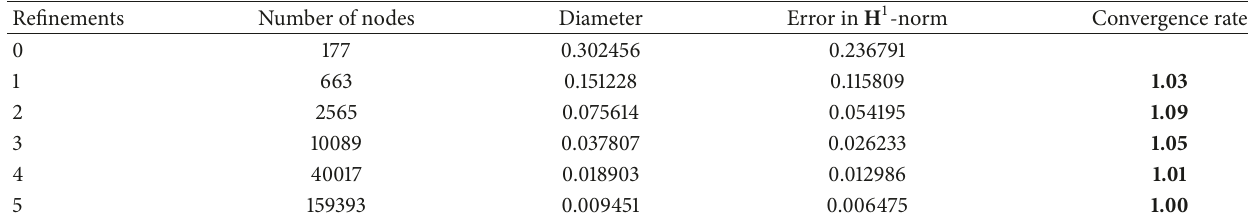
Table 3: Order of convergence in H 1 -norm for mixed Neumann-Dirichlet BC.